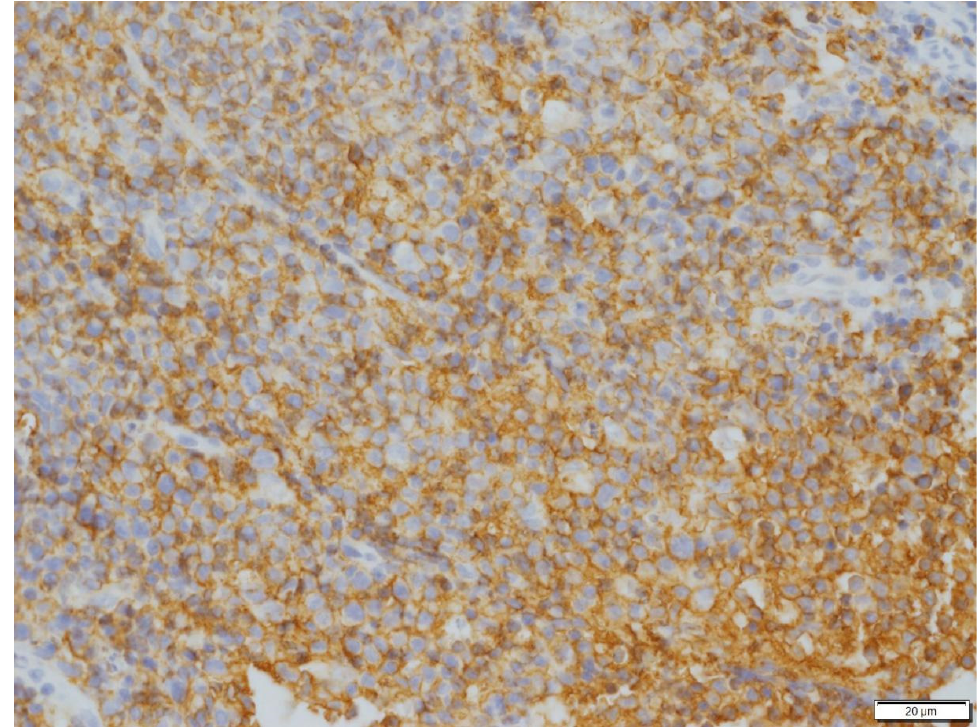
Figure 9. Immunohistochemical stain of neoplastic cells in Case N.3. Neoplastic cells